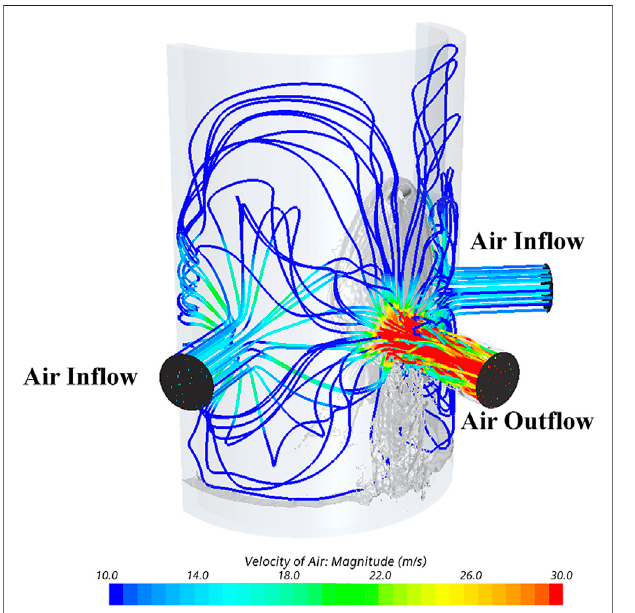
FIGURE 8 | Qualitative comparison of liquid fi lm behavior according to CFD and experiment. (A) Experiment. (B)